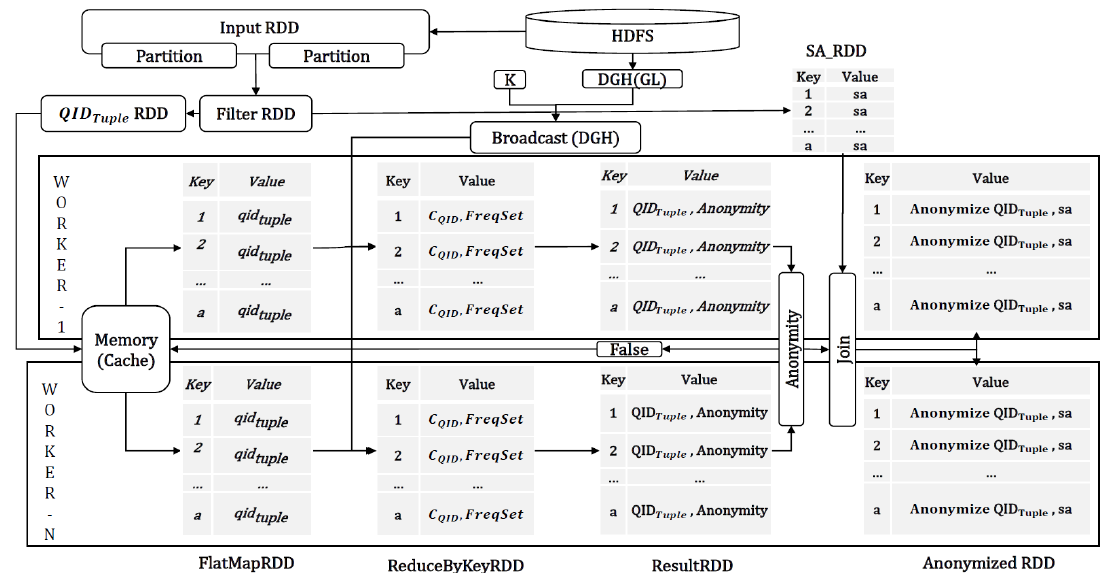
Figure 5. DataFlow in